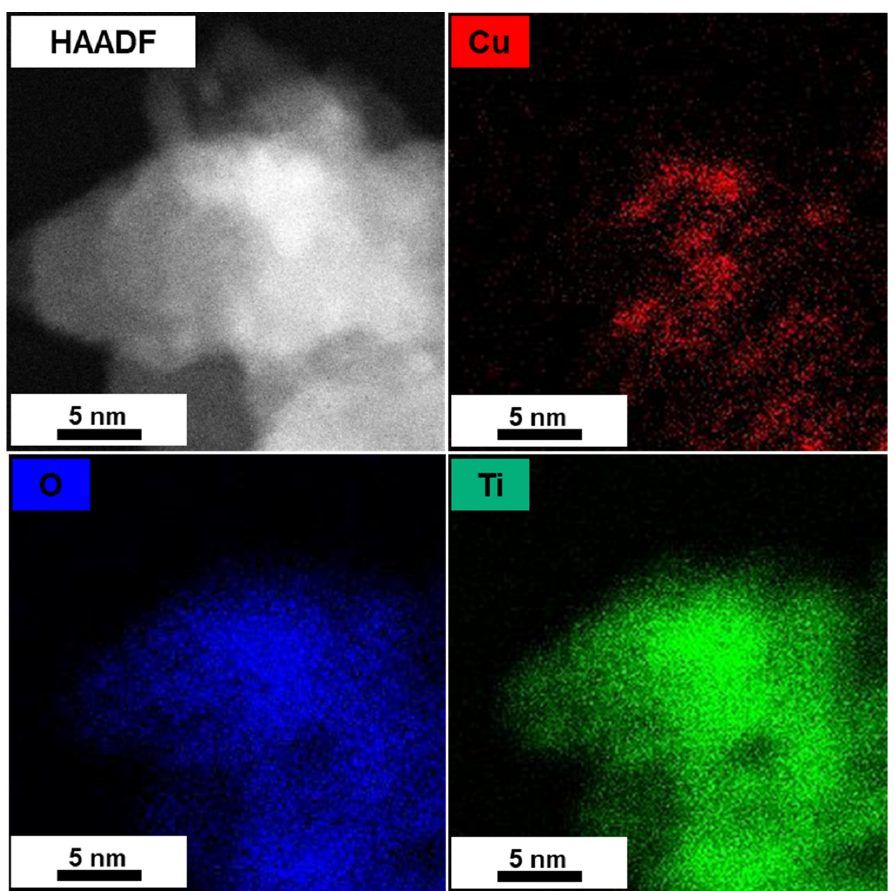
Figure 3. High-angle annular dark-field scanning transmission electron microscopy (HAADF- STEM) image and EDS mapping images of Cu-TiO 2 -H. image and EDS mapping images of Cu-TiO 2